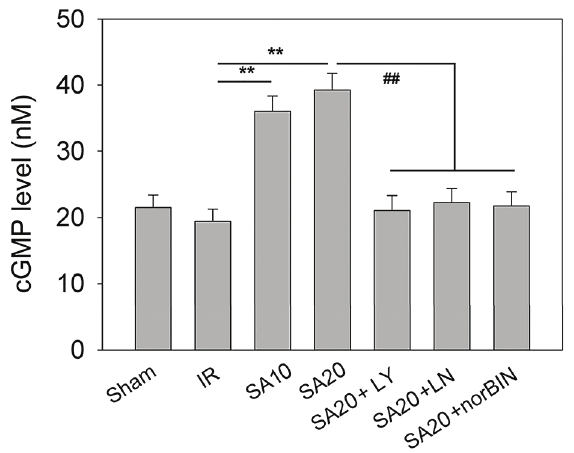
Figure 4. Measurement of cGMP levels in cerebrospinal fl uid from different treatment groups after cerebral cortex ischemia. SA10, SA20, SA20 + LY294002, SA20 + L-NAME, SA20 + norBIN were administered and the levels of cGMP were measured. Data are reported as means ± SD. **P o 0.01 compared to the IR (DMSO) group, ## P o 0.01 compared to the SA20 treatment group. The cGMP levels were analyzed by one-way ANOVA followed by Tukey ’ s test. LY: LY294002 (10 m M, injected topically); LN: L-NAME (10 m M, injected topically); IR (ischemia reperfusion control, DMSO): 1 m L/kg ( iv ); SA10: salvinorin A (10 m g/kg, iv ); SA20: salvinorin A (20 m g/kg, iv ); norBIN: norbinaltorphimine 1 m M (injected